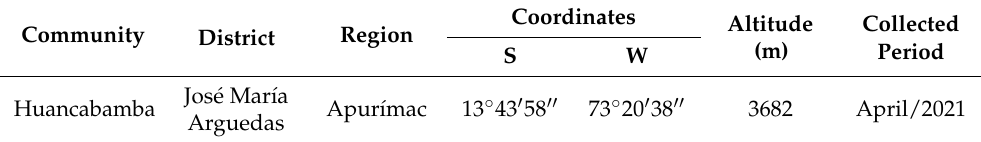
Table 1. Clay collection